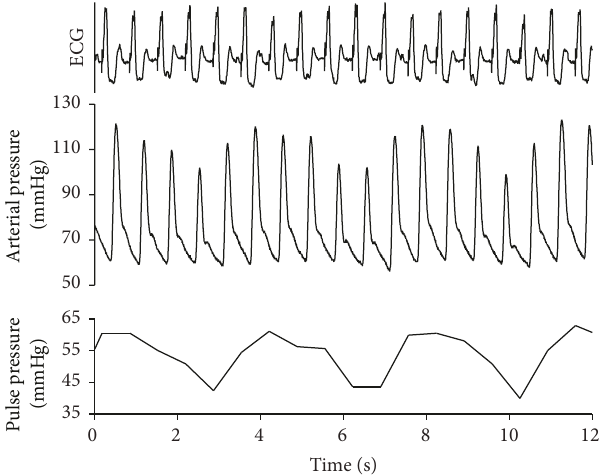
Figure 1: ECG, arterial pressure, and pulse pressure during pace- maker rhythm. The recording was taken shortly after the patient’s arrival to the ICU. Pacemaker spikes can be seen before every heartbeat, and the arterial pressure and pulse pressure indicate substantial fluctuations. The recordings were analyzed offline, and a pulse pressure diagram was also added.